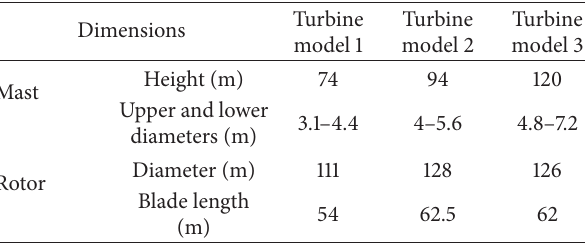
Table 1: Offshore wind turbine models used in the